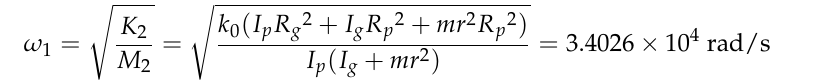
Figure 5. Two modes’ vibration displacement (periodical excitation). The internal resonance vibration absorber reduces the torsional vibration displace- ment amplitude, i.e., the gears’ relative displacement amplitude along the meshing line, to 26.48 μ m within 8 s, as shown in Figure 5. Compared to the system without the vibra- tion absorber (39.01 μ m), the vibration absorber reduces the amplitude of the gear tor- sional vibration by 32.1%. During this process, the energy of the gear torsional vibration mode is transferred to the vibration absorber mode via the internal resonance energy transfer channel and is continuously dissipated by the damping of the vibration absorber.